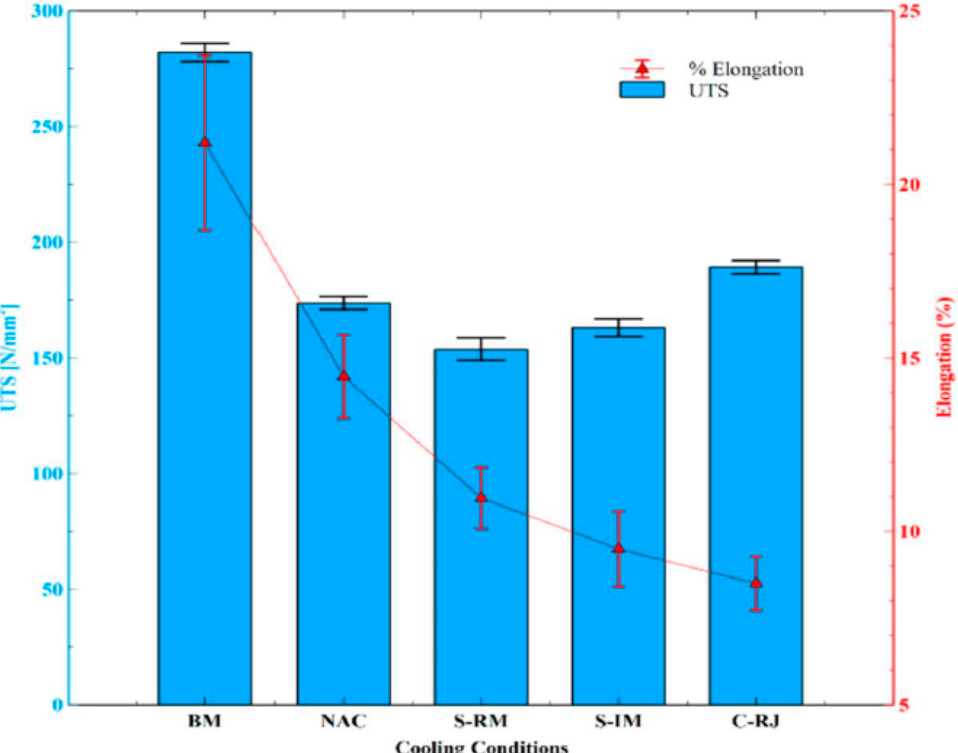
Figure 8. Tensile properties of joints produced with different cooling